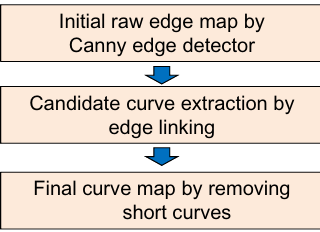
Figure 16. Curve map extraction using Canny edge detection, edge linking and short curve